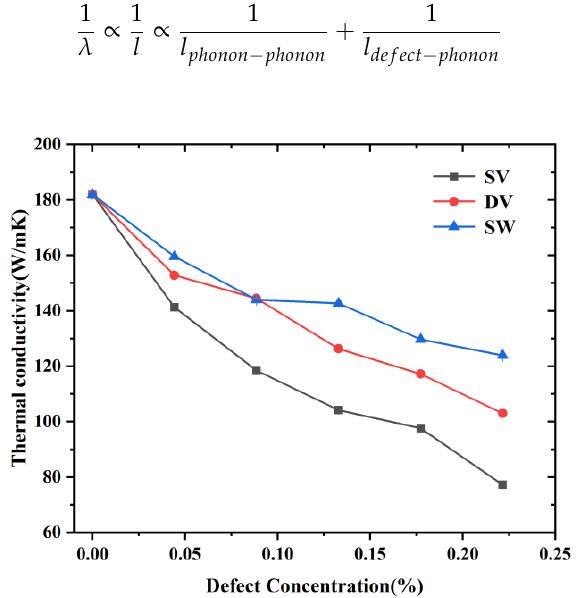
Figure 13. The TCs of Gr with different concentration at different types of defects.